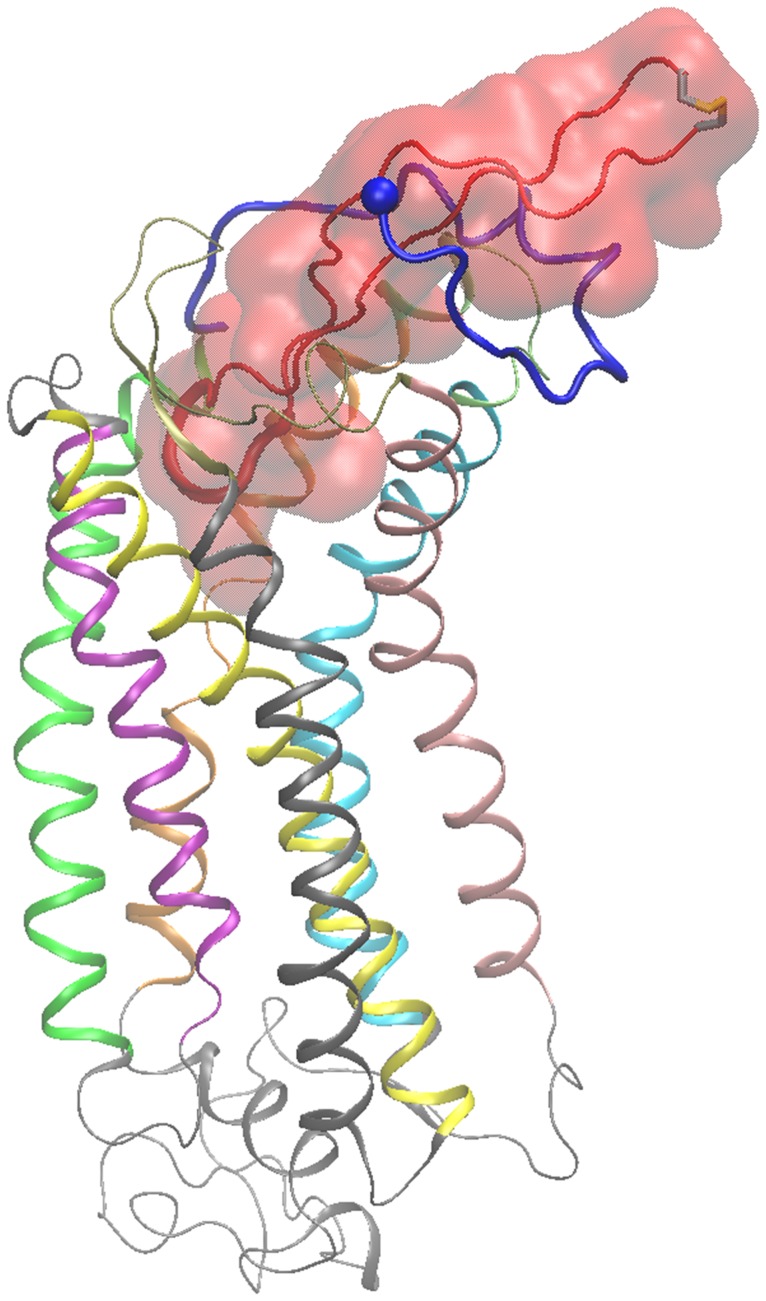
HIV-1 gp120 V3 loop : CCR5 Complex Structure;Molecular graphics image of the entire simulation system corresponding to the complex with the lowest average binding free energy. The V3 loop is shown in tube and transparent surface representation in red color, and the residue moiety 16–20 is shown in fat tube representation. The CCR5 is shown in cartoon representation, and the coloring used for different protein domains is as follows: (i) N-terminal domain is colored in blue, (ii) Transmembrane helix 1 (TH1) is colored in green; (iii) Intracellular loop 1 (ICL1) is colored in light gray; (iv) TH2 is colored in purple, (v) Extracellular loop 1 (ECL1) is colored in light gray; (vi) TH3 is colored in yellow; (vii) ICL2 is colored in light gray; (viii) TH4 is colored in gray; (ix) ECL2 is colored in ochre; (x) TH5 is colored in pink; (xi) ICL3 is colored in light gray; (xii) TH6 is colored in cyan; (xiii) ECL3 is colored in lime; (xiv) TH7 is colored in orange; (xv) C-terminal domain is colored in light gray. The N-terminal Cα atom of CCR5 is shown in a small van der Waals sphere and the V3 loop disulfide bridge is shown in fat transparent licorice representation. The definition of CCR5 and V3 loop domains is presented in Information S4.